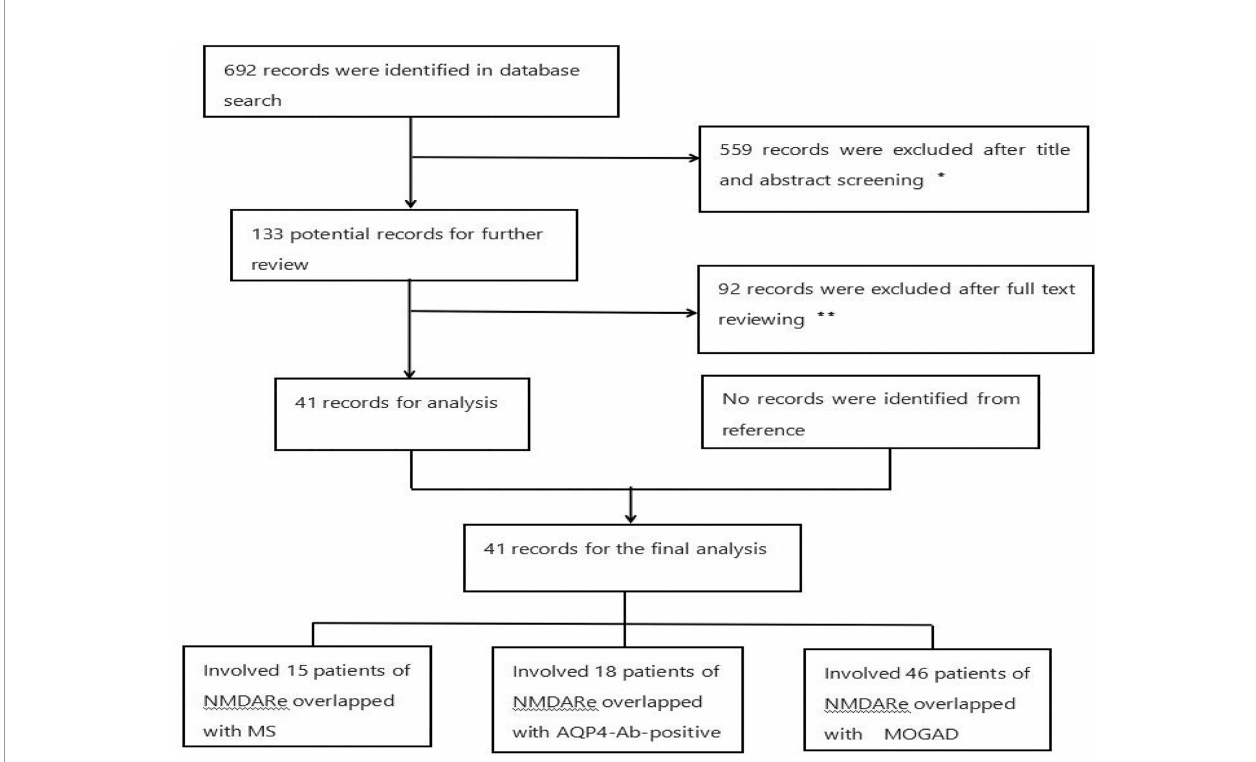
FIGURE 1 | Flowchart of the study. *Reviews and articles describing patients with a single disease were excluded. **Articles describing patients without key information or aquaporin-4-antibody-negative NMOSD were excluded. There were 15, 18, and 46 NMDARe patients overlapped with MS, AQP4-Ab-positive NMOSD, and MOGAD,